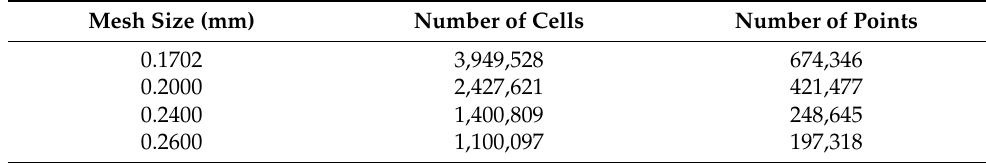
Table 9. Mesh information for CT209 model [19].